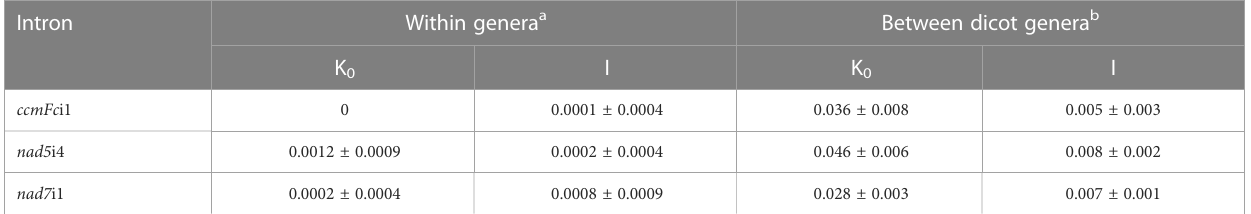
TABLE 7 Average nucleotide substitutions (K 0 ) and indels (I) per site within genera and between dicot genera b . Intron Within genera a Between dicot genera